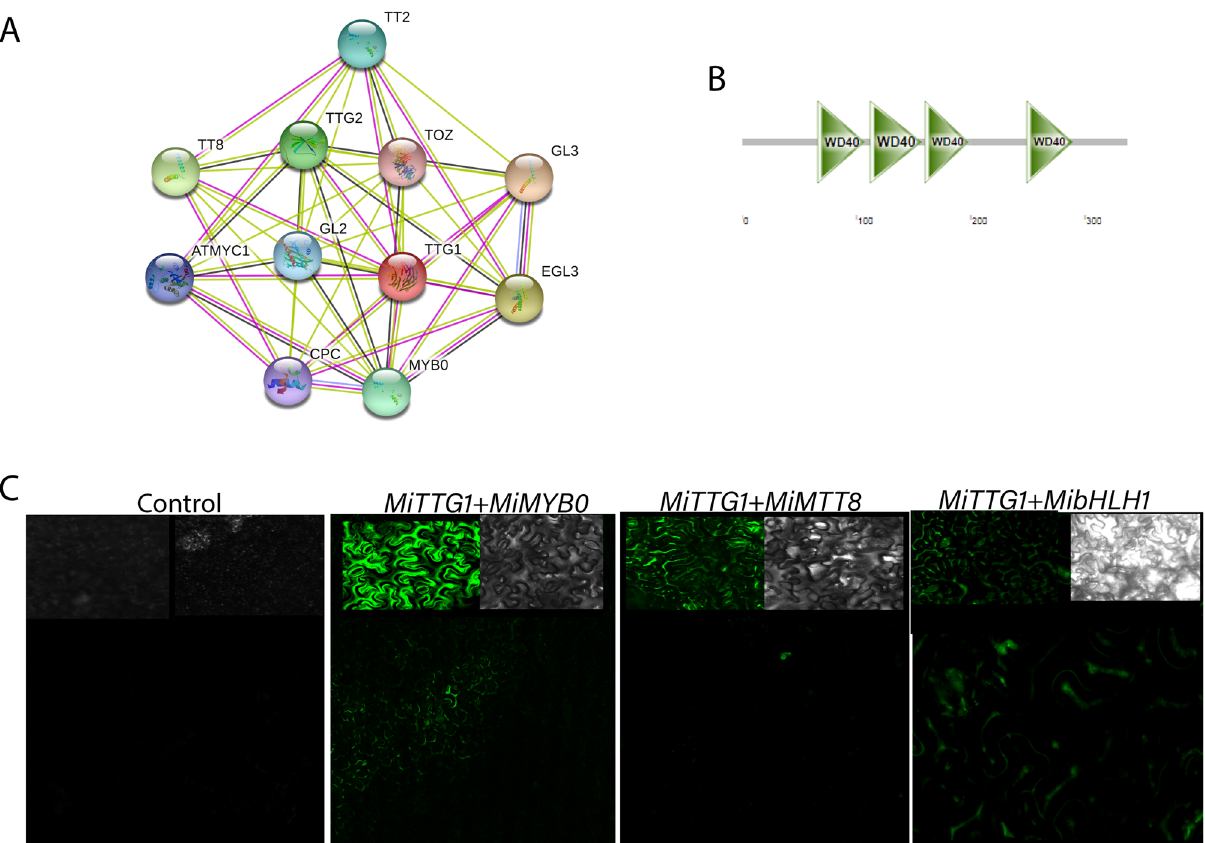
Figure 2. Protein–protein interaction networks of MangoWD40 proteins. ( A ) The prediction of protein interaction networks of WD40 with other transcription factors by STRING database. Each node is represented a protein and each edge is represented an interaction between two proteins. ( B ) Four conserved motifs of MiTTG1 protein. ( C ) MiTTG1 physically interacts with MiMYB, MiTT8 and MibHLH transcription factors in tobacco leaves were observed by confocal